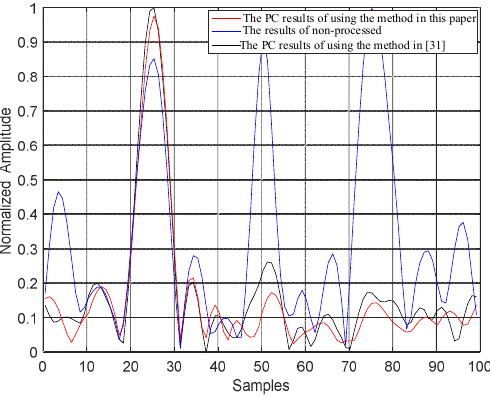
Figure 6. The root mean square error of estimated slice width varies with slice width.